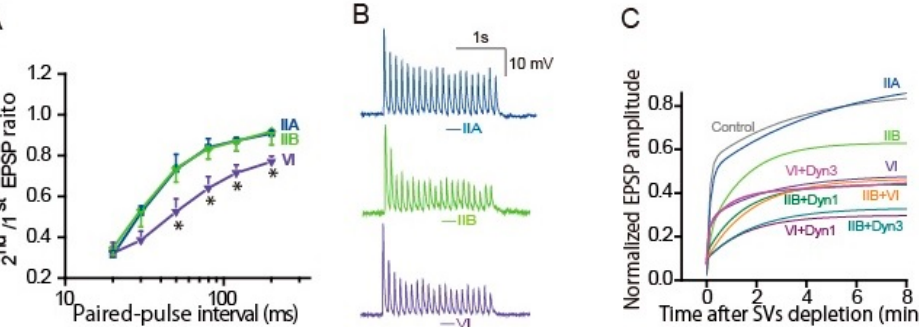
Figure 4. Myosin IIB and VI support release ‐ ready SV restoration. Presynaptic neurons were trans ‐ fected with control, myosin IIA ‐ , IIB ‐ , or VI ‐ siRNA 2–3 days before the EPSP recordings. ( A ) Myo